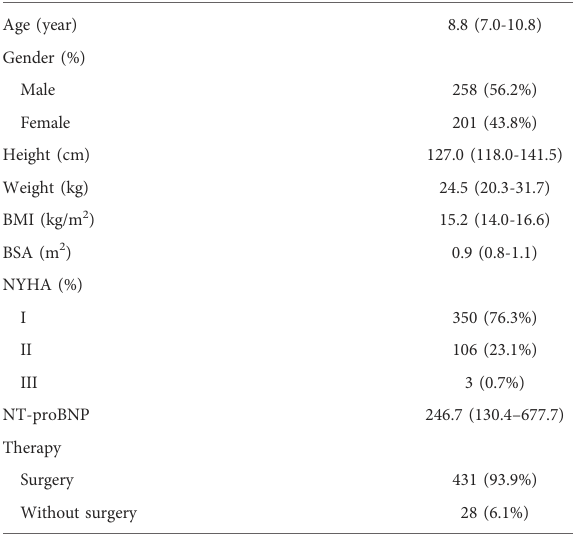
TABLE 2 Patient ’ s baseline characteristics.